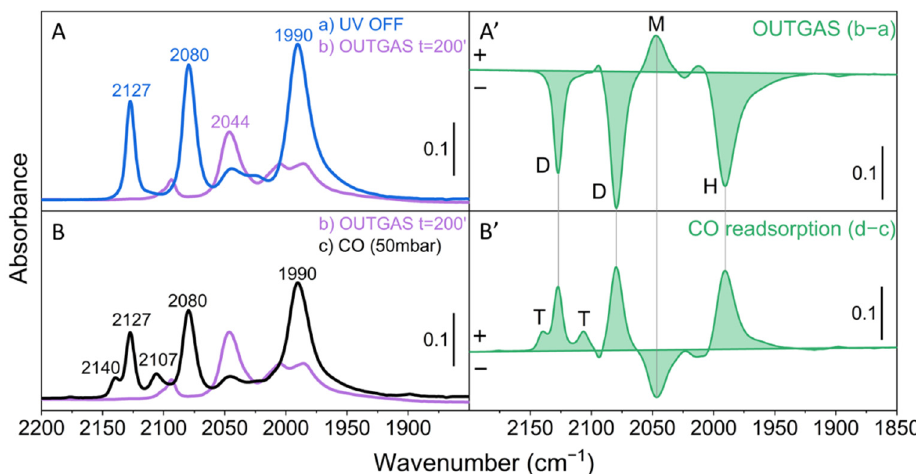
Figure 3. FT-IR spectra of Mo/SiO 2 after photoreduction in CO. ( A ) Comparison of the spectra after stopping the UV irradiation (blue curve) and after 200 min of CO evacuation in dark conditions (purple curve). ( B ) Comparison of the spectra of the outgassed sample and after readmission of CO at 50 mbar (black curve). The spectrum of the oxidized material in the presence of CO gas, before UV irradiation, has been subtracted from all spectra. ( A’ ) Difference spectrum (b − a) to underline the effect of CO evacuation. ( B’ ) Difference spectrum (d − c) showing the effect of CO readsorption. The letters T, D, M and H refer to the molybdenum species shown in Figure 1.